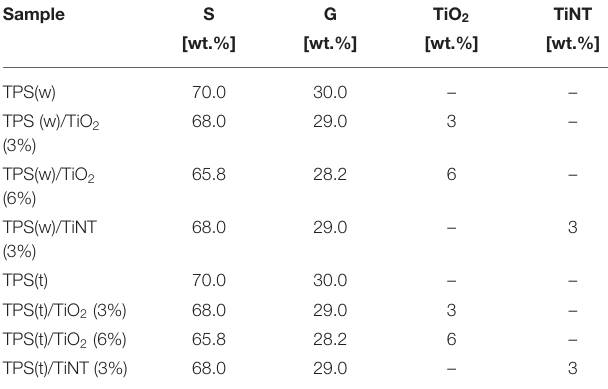
TABLE 1 | List of prepared TPS-based